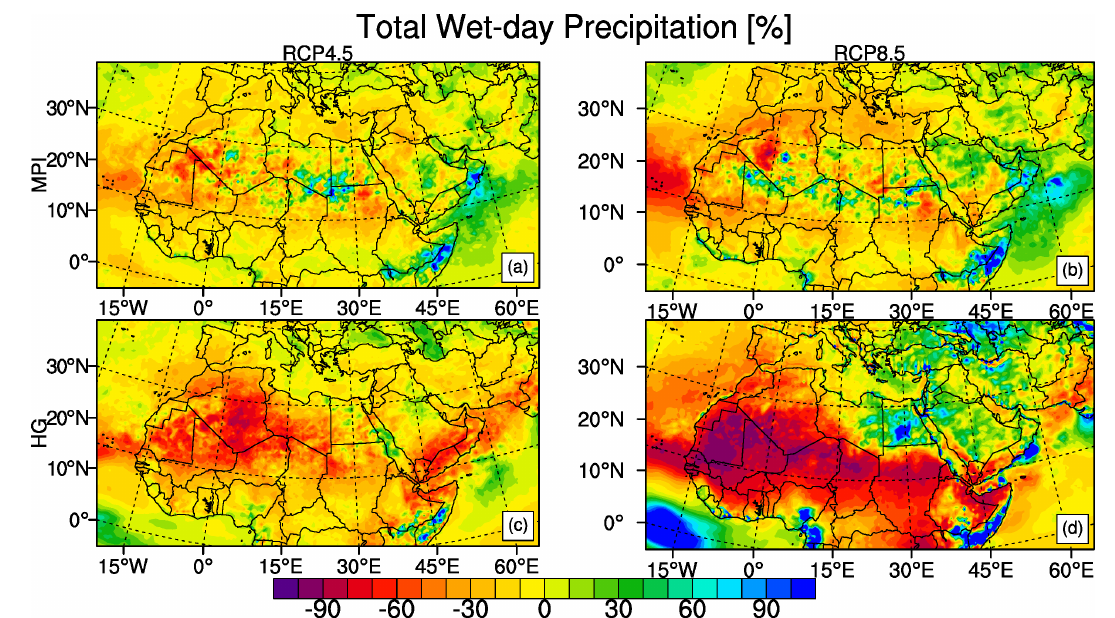
Figure 9. The temporally averaged changes in the total wet-day precipitation (PRCPTOT) for the period of 2071–2100 displayed as differences (in %) with respect to the reference period 1971–2000 for the model MPI-ESM-MR with RCP4.5 ( a ) and RCP8.5 ( b ) and for the model HadGEM2-ES with RCP4.5 ( c ) and RCP8.5 ( d ).